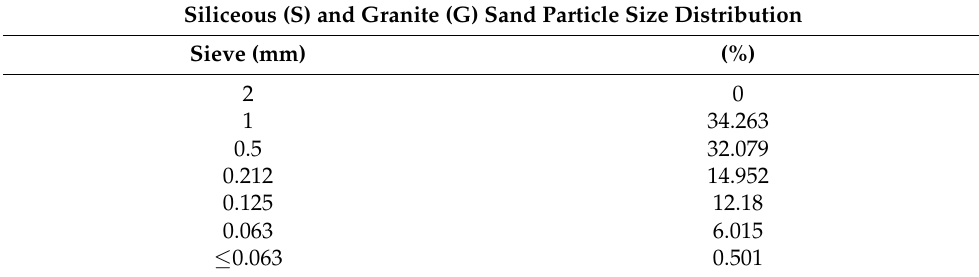
Table 5. Particle size distribution of sands used to prepare the mortars. Siliceous (S) and Granite (G) Sand Particle Size